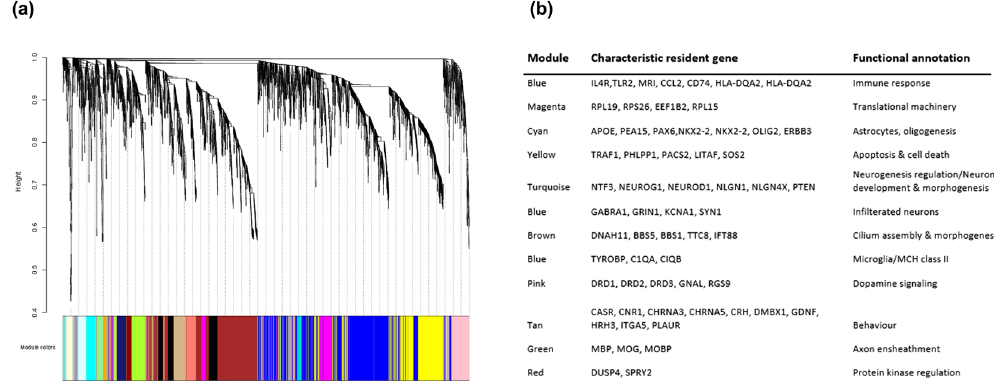
Figure 3. ( a ) Weighted gene coexpression network and gene modules. Dendogram depicting distinct colored modules of co-expressed genes. Using topological overlap as the dissimilarity measure and average linkage unsupervised hierarchical clustering of genes, 19 modules of co-expressed genes were identified by implementing dynamic branch cut to the dendogram. Each module was assigned a unique number (M1 to M19) and color. (b) Functional annotation of the modules: Genes that are characteristic of their module of residence have been carefully noted along with the top overrepresented functional (Biological process or molecular function) terms for each